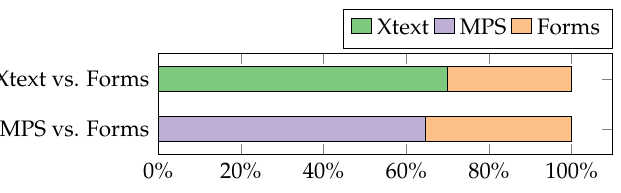
Figure 9. Editor type students would prefer in the